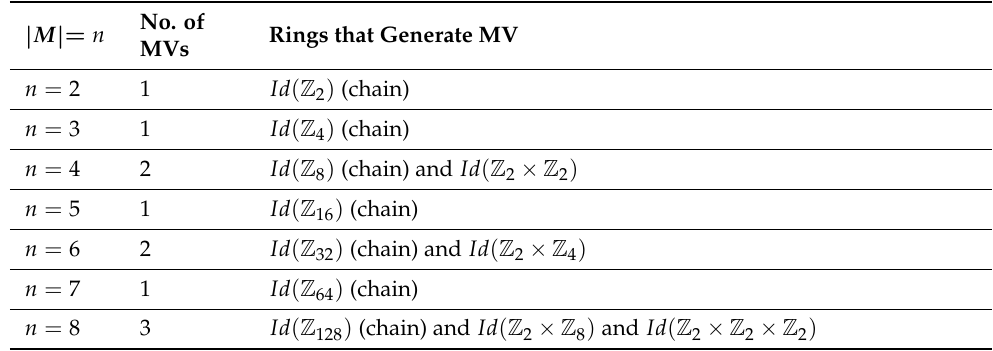
Table 1. Rings that Generate MV-algebras of order n , 2 ≤ n ≤ 8. No. | M | = n